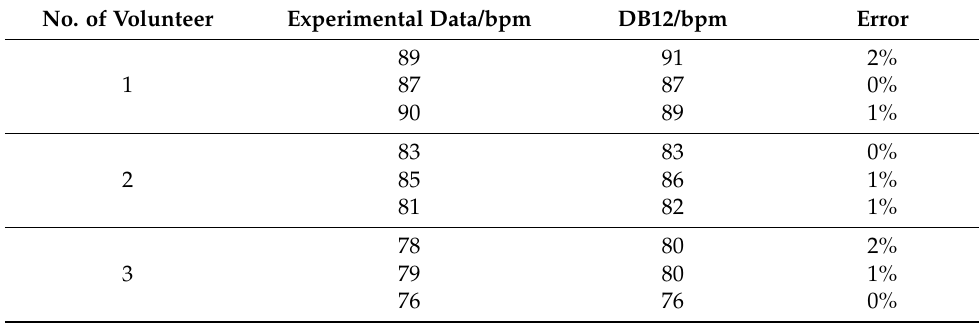
Table 2. Comparison of heart rate with DB12 blood oxygen monitor.